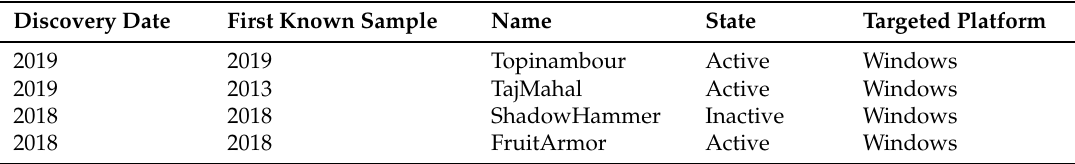
Table 2. Latest APT campaigns discovered (adapted from